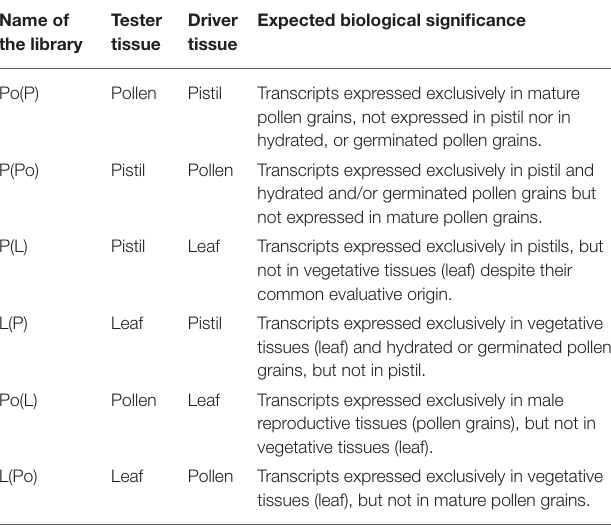
TABLE 3 | Putative composition and nature of the transcripts present in the generated SSH libraries. Name of Tester the library